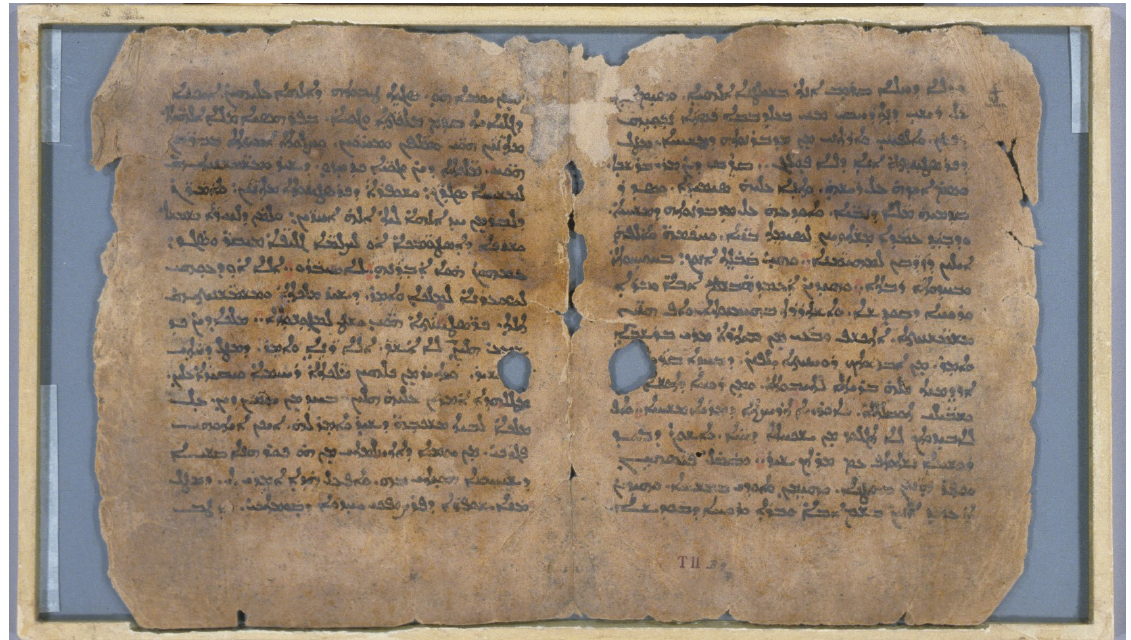
Figure 6 SyrHT 45-46, side b, ll.9-10. Mart Shir repudiates the Zoroastrian